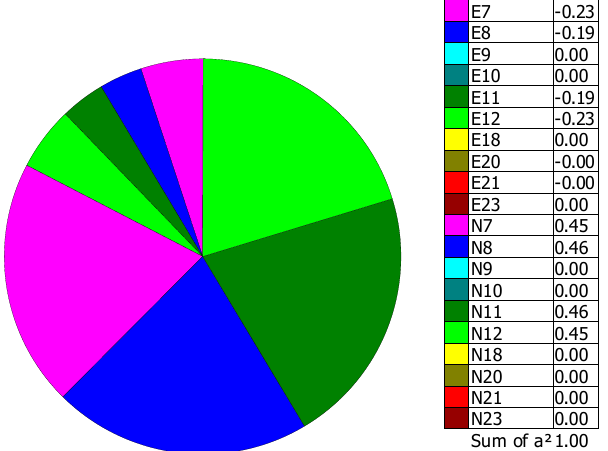
Figure 10. Representative α i for random variables (advanced model).